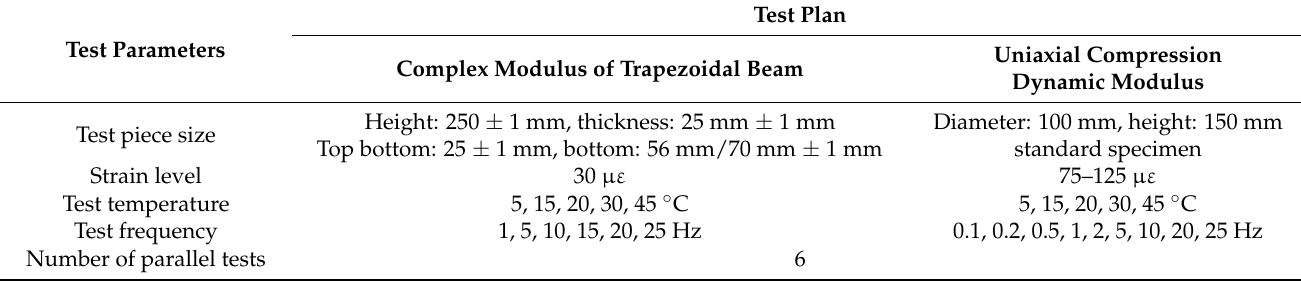
Table 7. Test schemes of mixture stiffness modulus under different evaluation